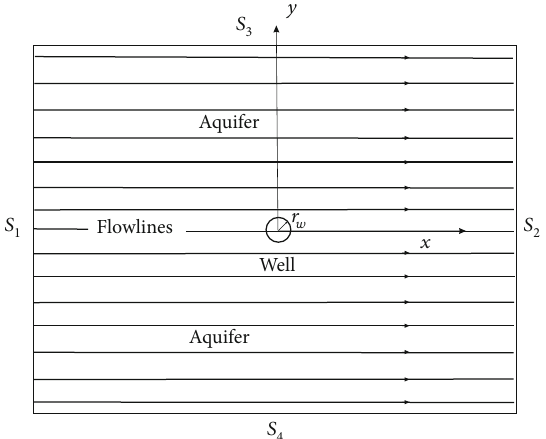
Figure 2: The schematic diagram of the fl ow system. S are the boundaries of the model, and S S 4 boundaries; both S